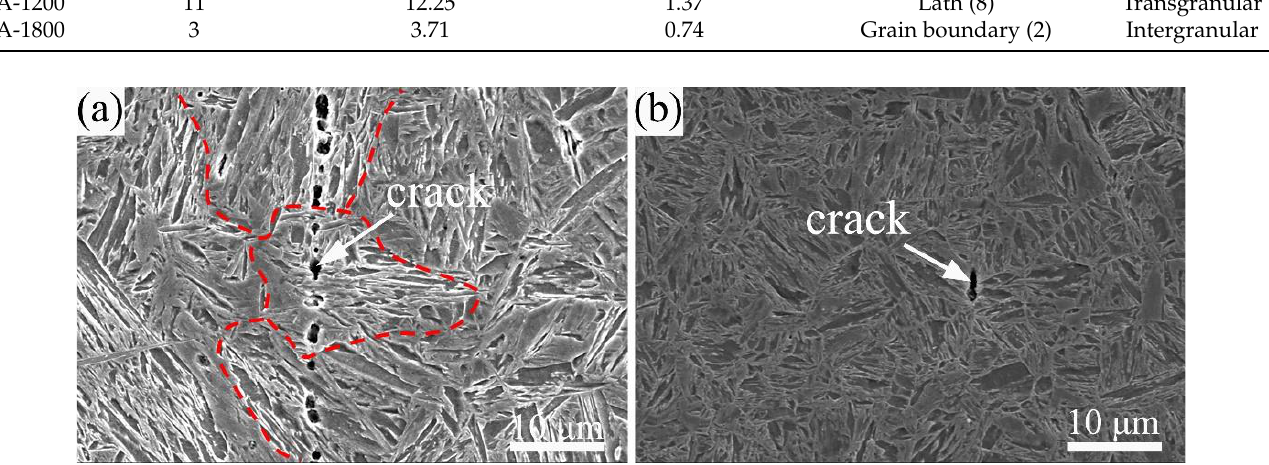
Figure 8. SEM images of crack distribution: ( a ) A-1200 and ( b ) A-1800 samples. The kernel average misorientation (KAM) maps of both samples are shown in Figure